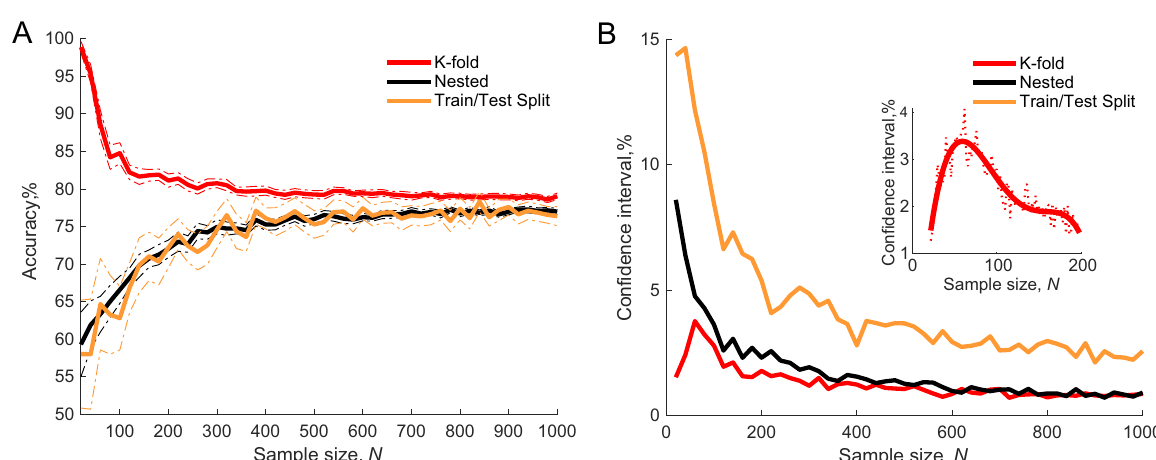
Fig 7. Classification with discriminable data using K-Fold CV, Nested CV and Train/Test Split validation methods. A : Comparison of different validation methods. Dash-dot lines show 95% confidence intervals for 50 runs. B : Size of 95% confidence intervals. Inset plot shows more refined view of confidence intervals for K-fold CV in a sample size range of 20 to 200 (in the inset plot sample sizes were N = 20, 22, ... 198, 200, in the main plot N = 20, 40, ... 980, 1000).